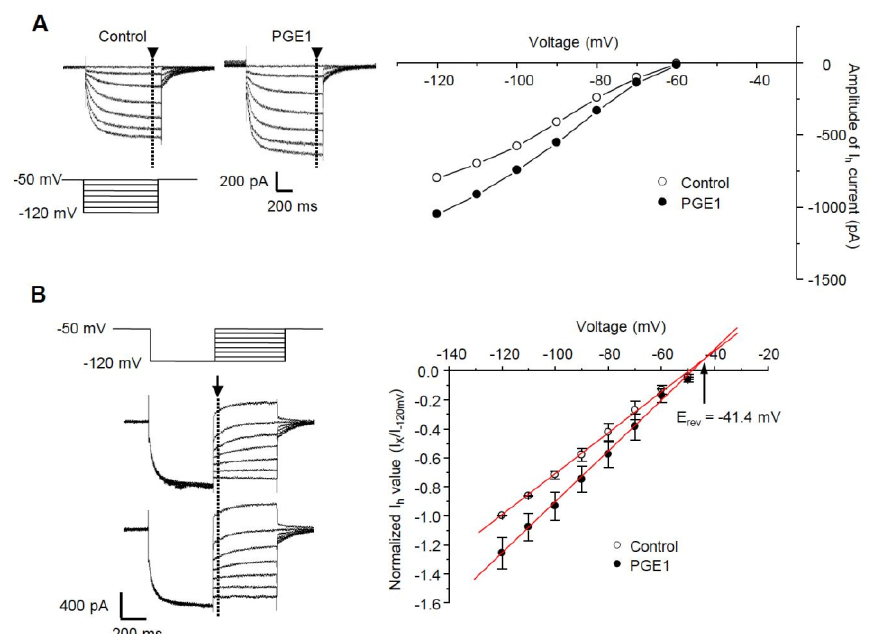
Figure 3. The current-voltage relationship and effects of PGE1 on reversal potential. ( A ) Left: I h was evoked by hyperpolarizing test pulses of − 50 mV to − 120 mV in 10 mV increments from V h of − 50 mV. Representative recordings of I h superimposed before and during exposure to PGE1 (100 nM). Right: Current-voltage relationships were measured at the end of the pulse (arrowhead). ( B ) Left: the reversal potential (E rev ) was determined by applying a − 120 mV hyperpolarizing prepulse for 500 ms then depolarizing in 10 mV increments from − 120 mV to − 50 mV. Represen- tative recordings of superimposed I h before and during exposure to PGE1 (100 nM). Right: Mean instantaneous I h (arrow) was plotted with respect to voltage and a linear regression was performed. Arrow indicates reversal potential of I h . Results are presented as the mean ±